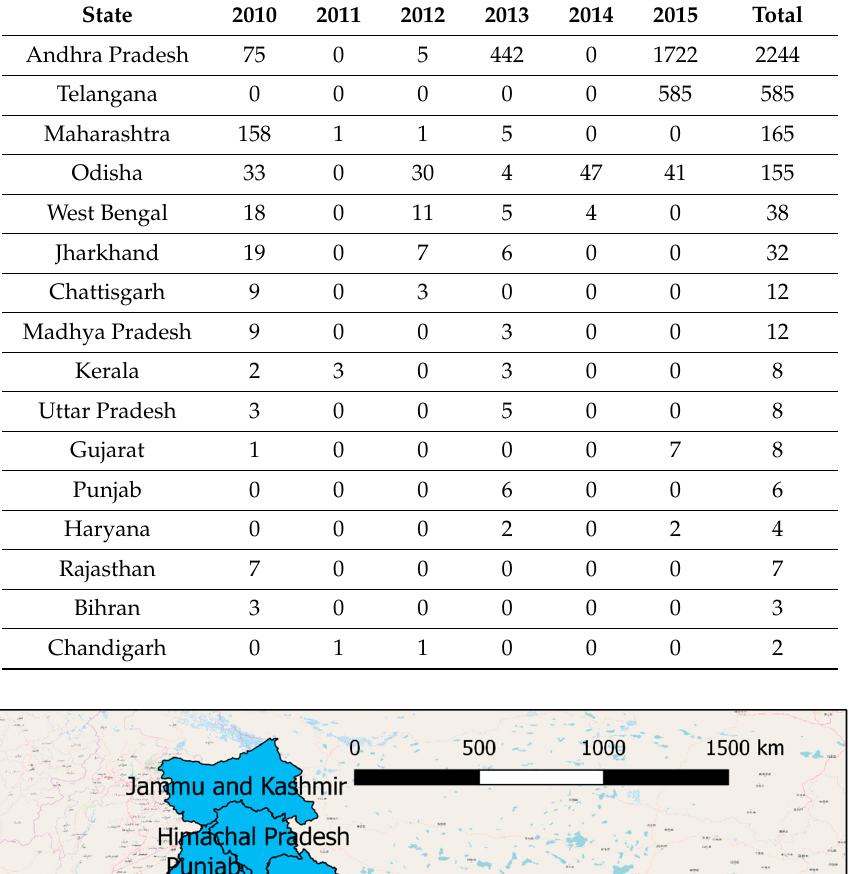
Table 1. Number of heat-related deaths per year per Indian state according to IMD weather reports. State